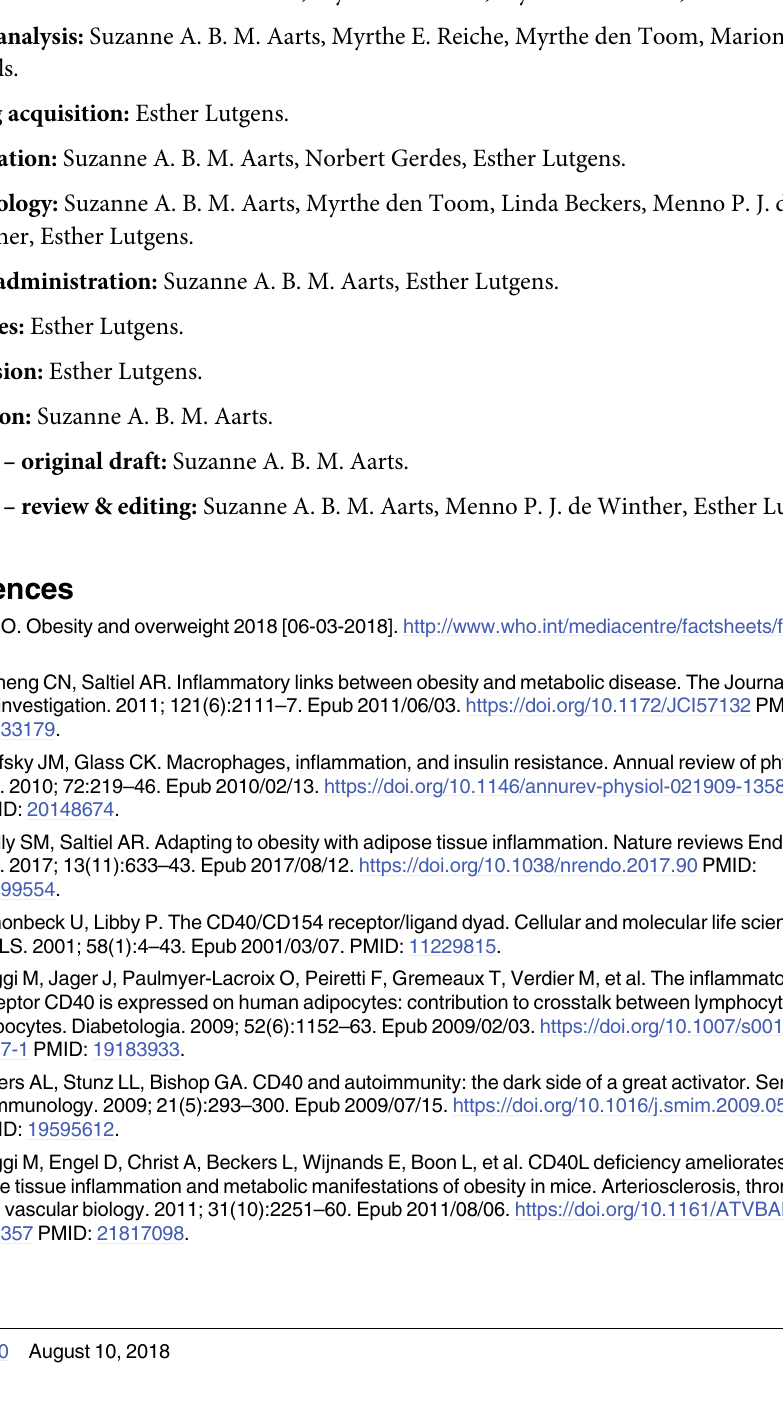
S2 Fig. Representative pictures of CD45, Mac3, and CD3 staining of epAT from CD40 flfl LysM cre and WT mice. Scale bar is 100